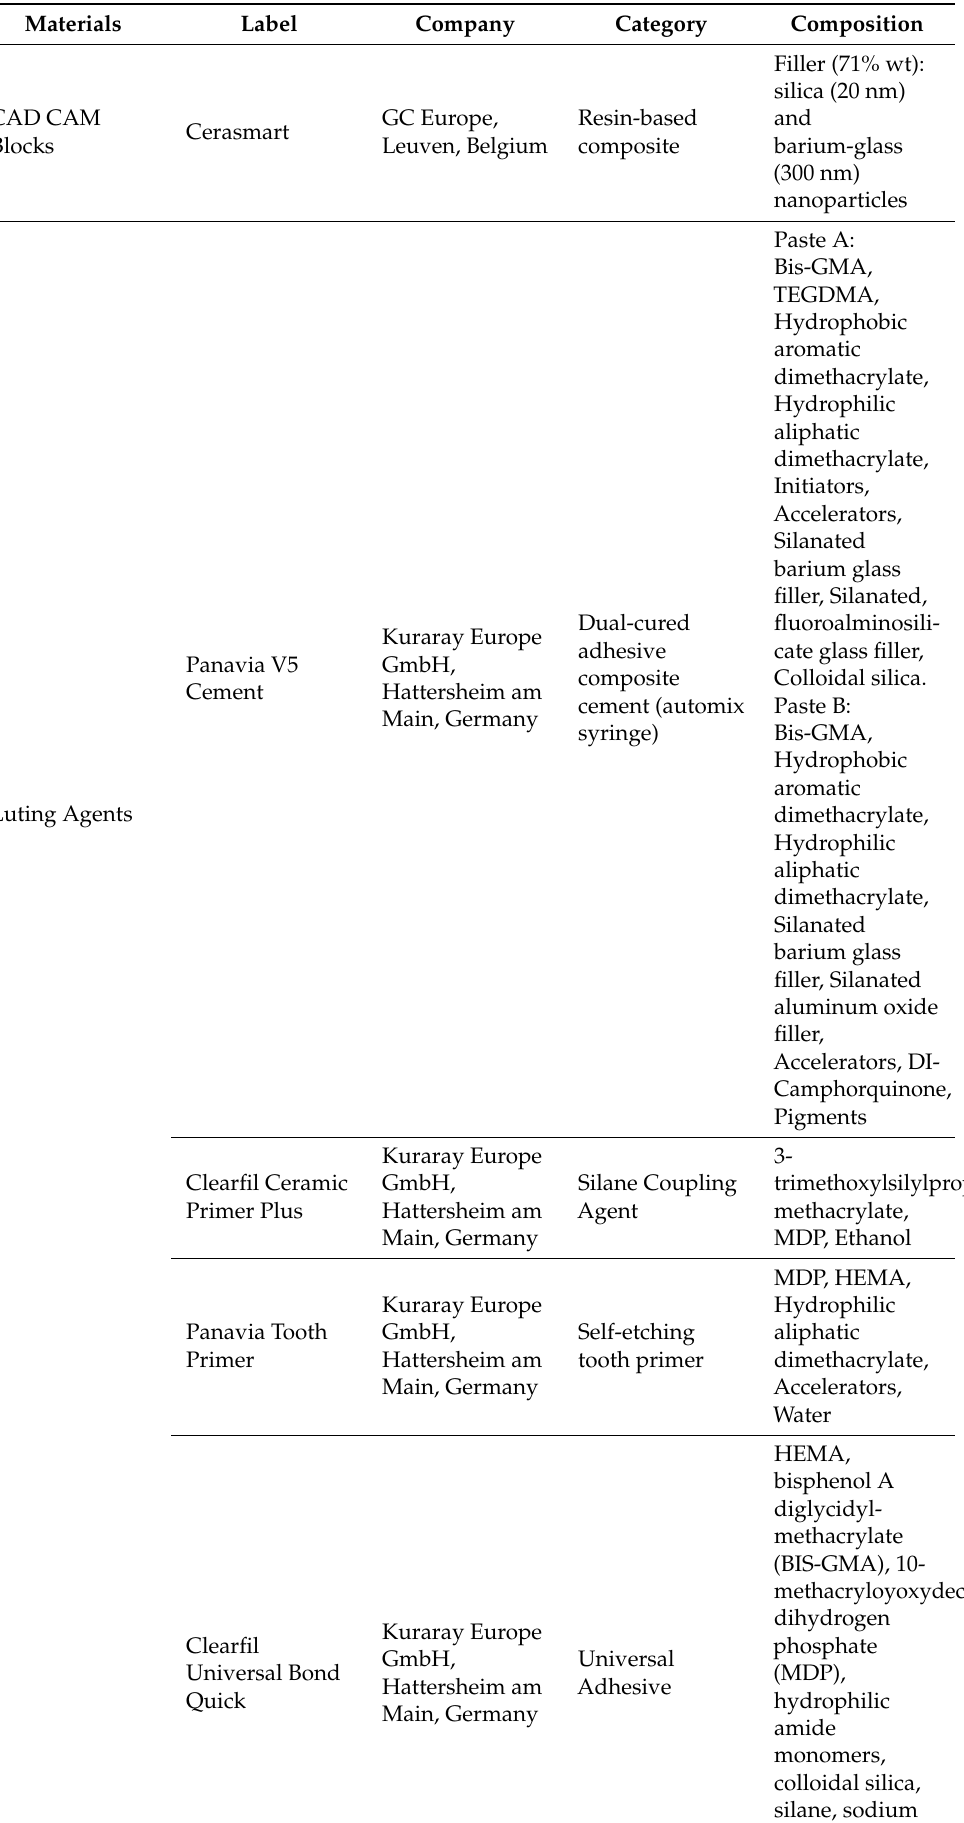
Table 1. Materials employed in the